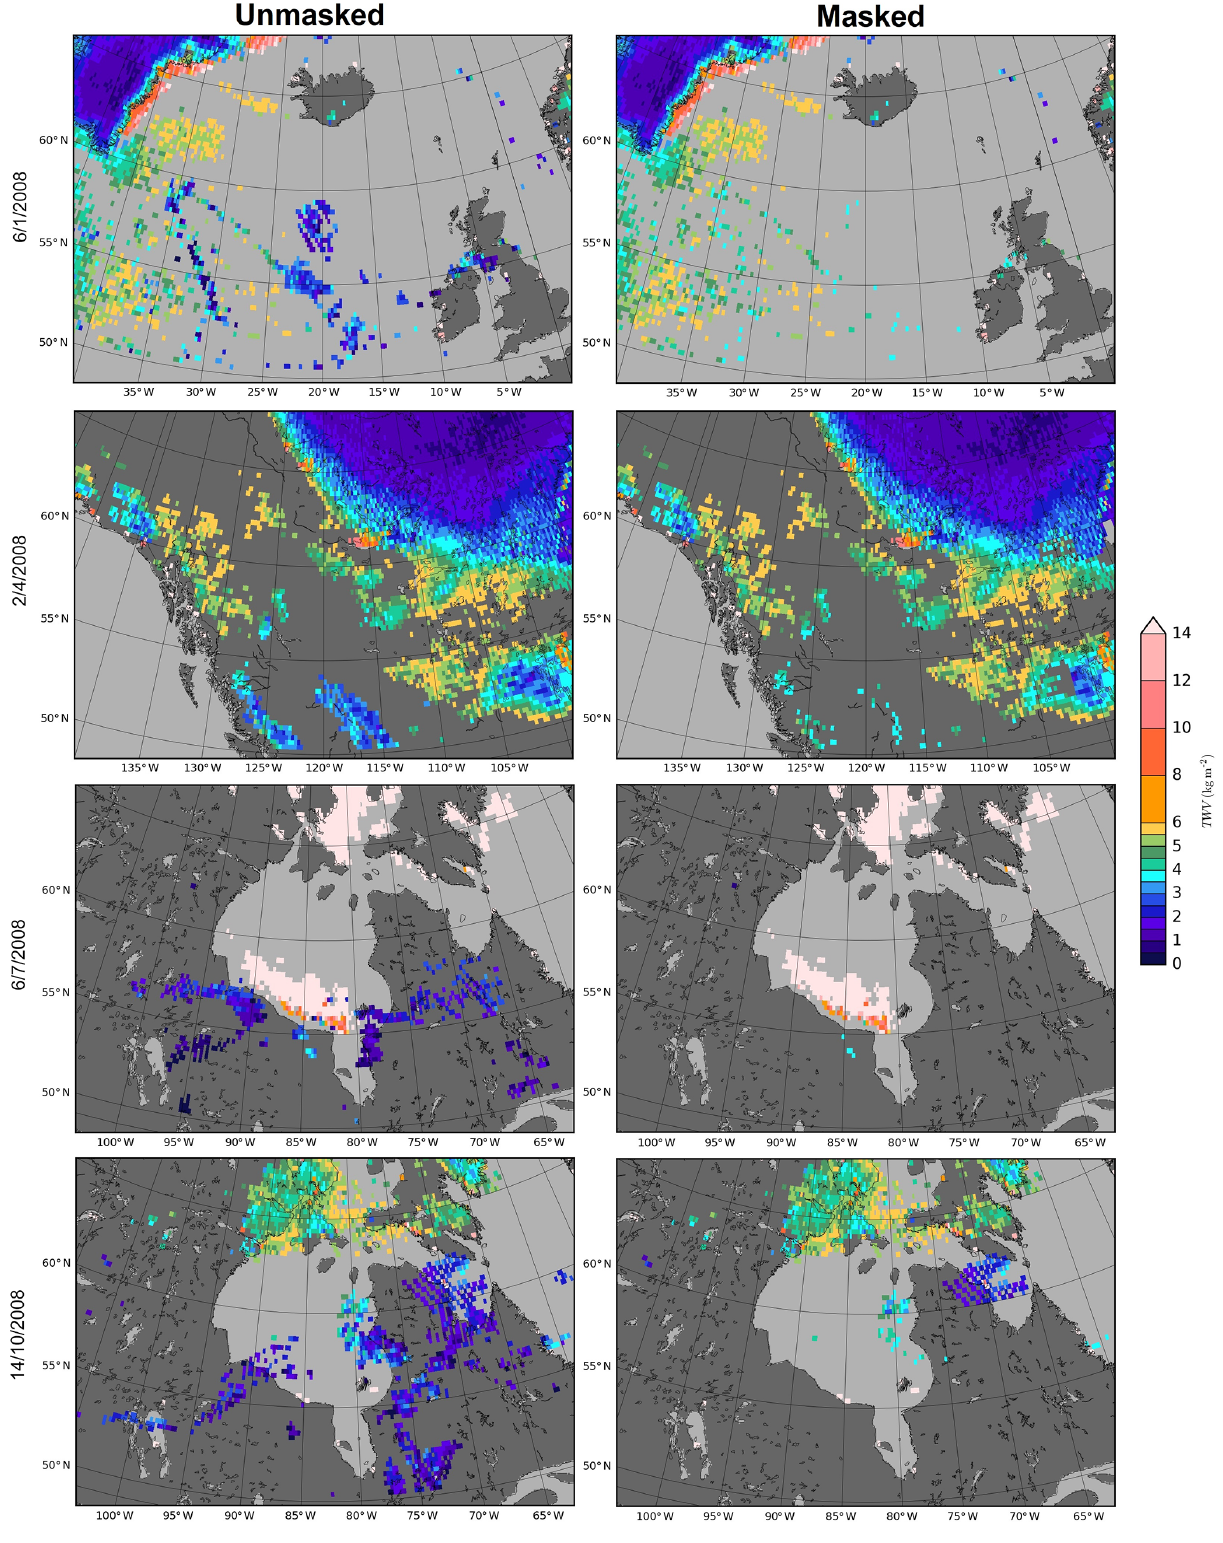
Figure 13. Unmasked (left column) and masked (right column) AMSU-B TWV retrieval for different showcased areas of 4d in 2008: 6 January (top row), 2 April (second row), 6 July (third row) and 14 October (bottom row). Please note the different location in each